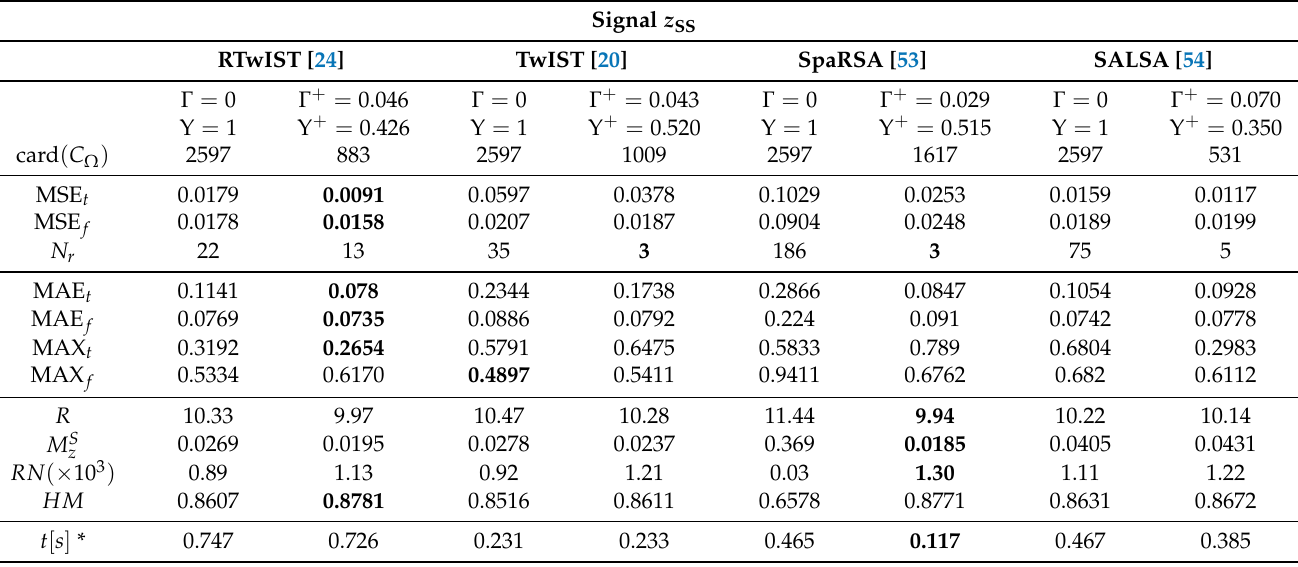
Table 1—all global measures erroneously favor the oversparse reconstructed TFD. Table 2. Performance of the state-of-the-art reconstruction algorithms with the full N (cid:48) τ × N (cid:48) ν area ( ( Γ , Υ ) = ( 0,1 ) ) versus the proposed CS-AF area selection ( Γ + , Υ + )